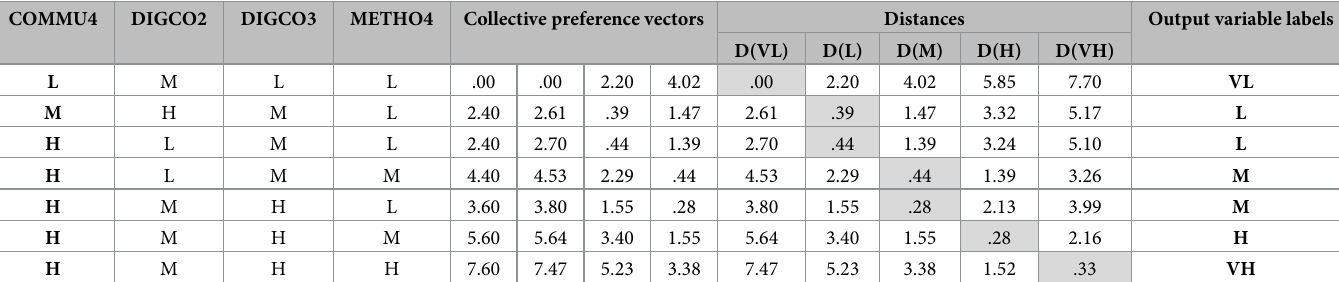
Table 5. Collective preference vectors of input variables and label assignment in the evaluation model rule-base. COMMU4